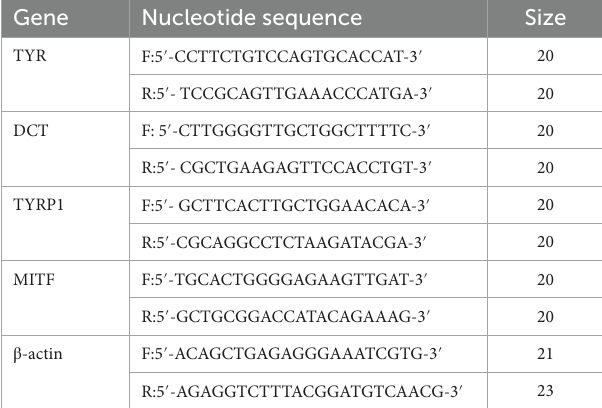
TABLE 1 The sequences of primers used for reverse